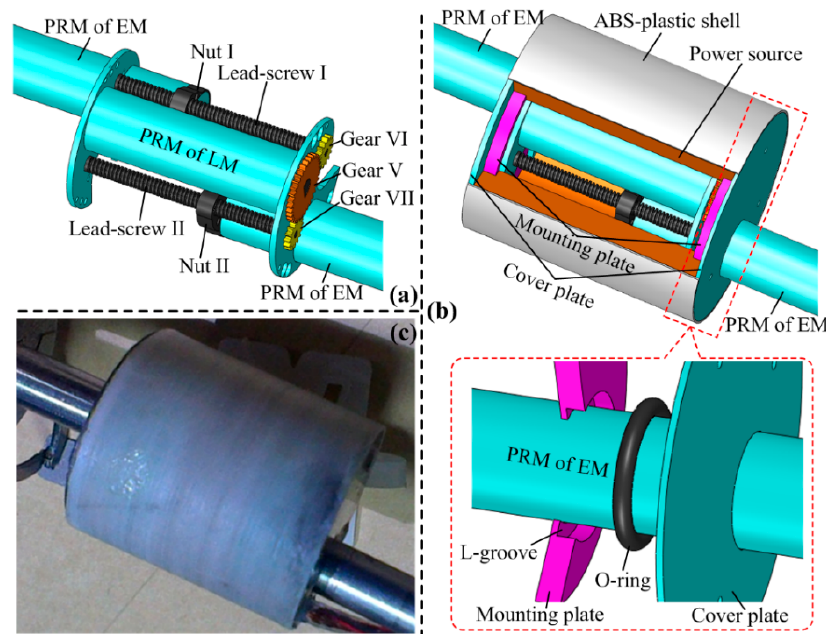
Figure 3. ( a ) Working principle of the linear mechanism (LM); ( b ) sealing design of the LM; ( c ) fabricated prototype of the LM. Table 4. Design parameters of the Linear Mechanism (LM).